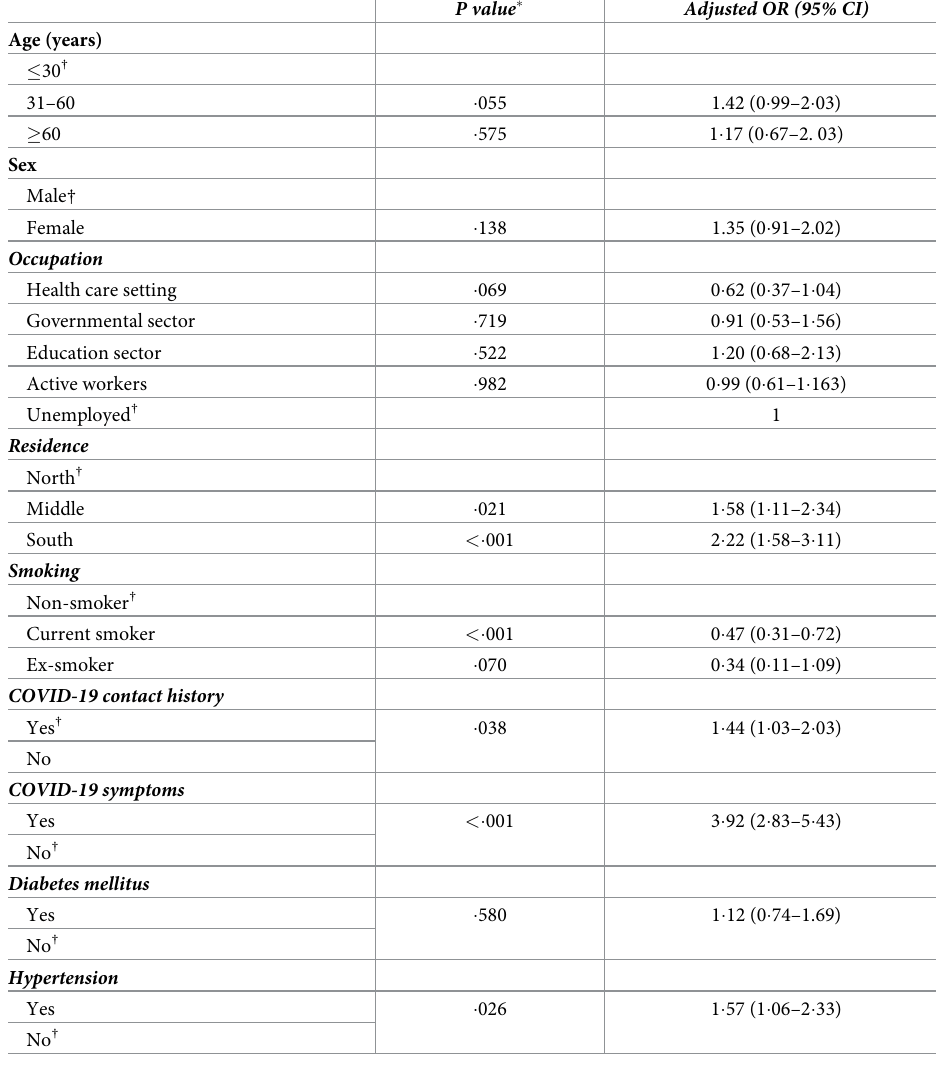
Table 2. Multivariate model of factors independently associated with SARS-CoV-2